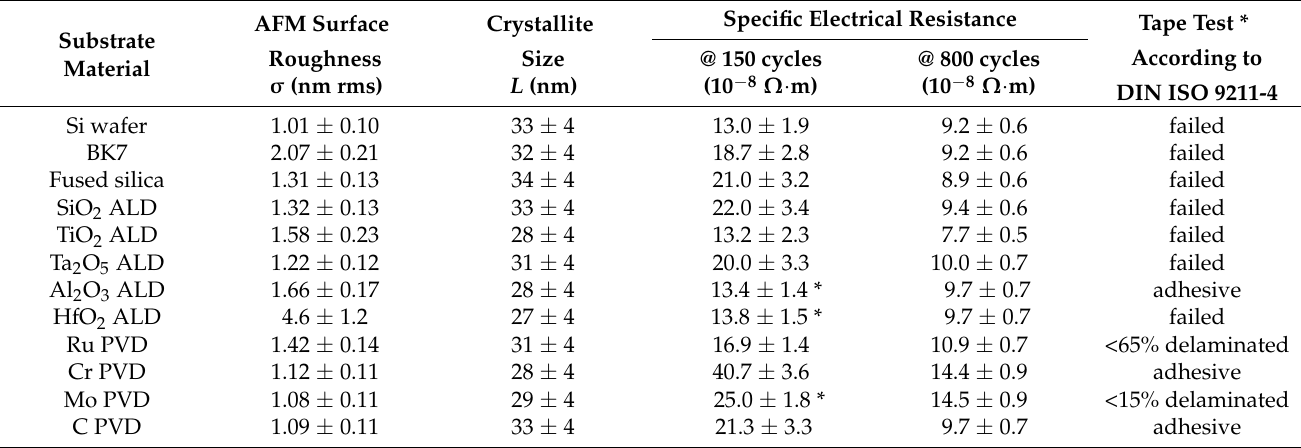
Table 1. Layer properties of Ir coatings on different substrate materials. The AFM surface roughness (from Figure 9), estimated crystallite size, and specific electrical resistance are obtained from thicker Ir coatings with 800 ALD cycles. Additionally, the specific electrical resistance for thinner coatings with 150 cycles (330 cycles on Al 2 O 3 , HfO 2 , and Mo marked with an asterisk) is given. Tape tests were performed on Ir coatings with 330